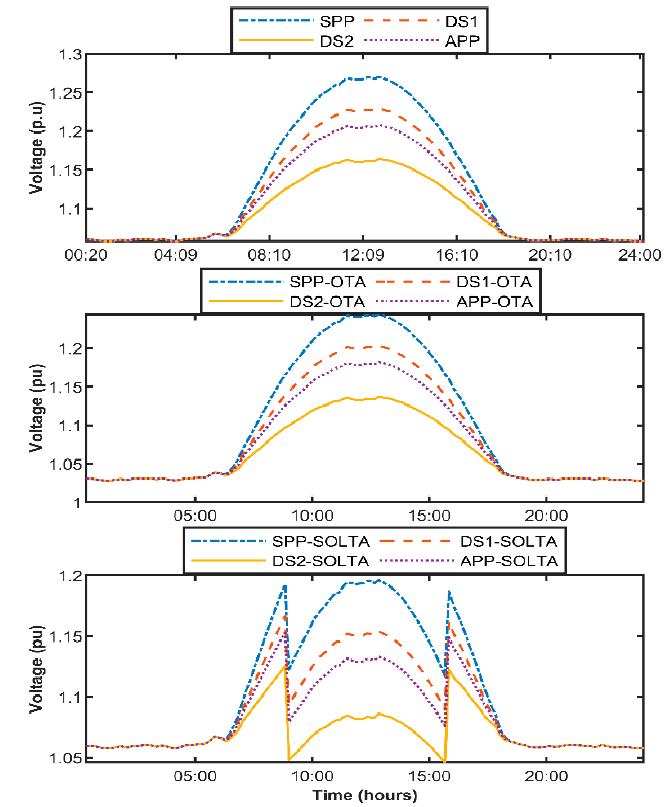
Figure 14. ∆ Max day voltage profiles at critical bus R15: 74% PV penetration.